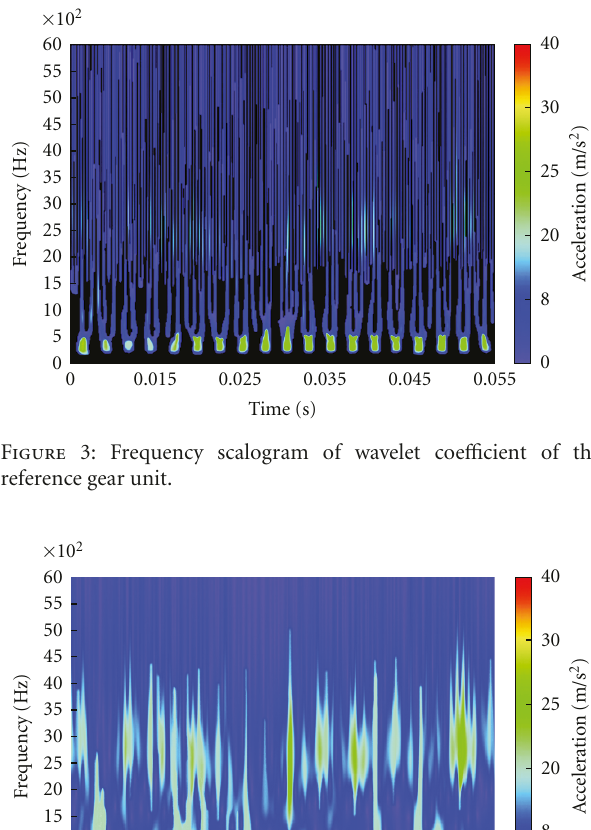
Figure 2: Pinion with a fatigue crack in the tooth root [21].